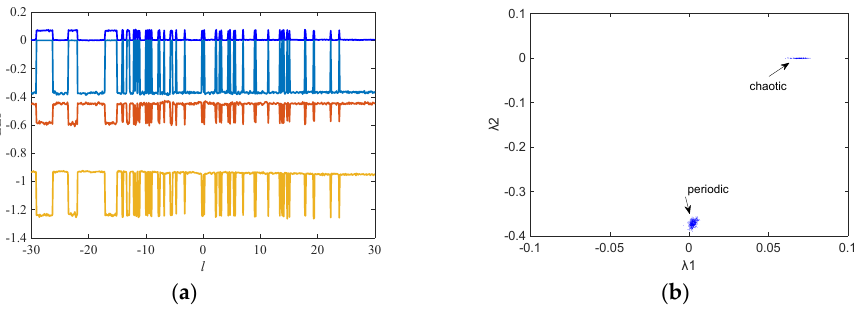
Figure 15. Dynamical behaviors of System (14) on the initial condition (0.1, 0, − 1, 0.1) versus offset booster l ( l ∈ [ − 30, 30]): ( a ) Lyapunov exponent spectrums, ( b ) distribution of Lyapunov exponents.